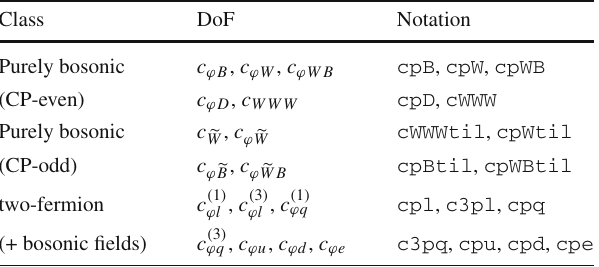
Table3 Overviewofthedegreesoffreedomconsideredinthisanalysis, separated into purely bosonic (upper) and two-fermion (lower part) operators. We also indicate the notation that will be used in some of the plots and tables of the following sections See Tables 1 and 2 for their definitions in terms of the SM